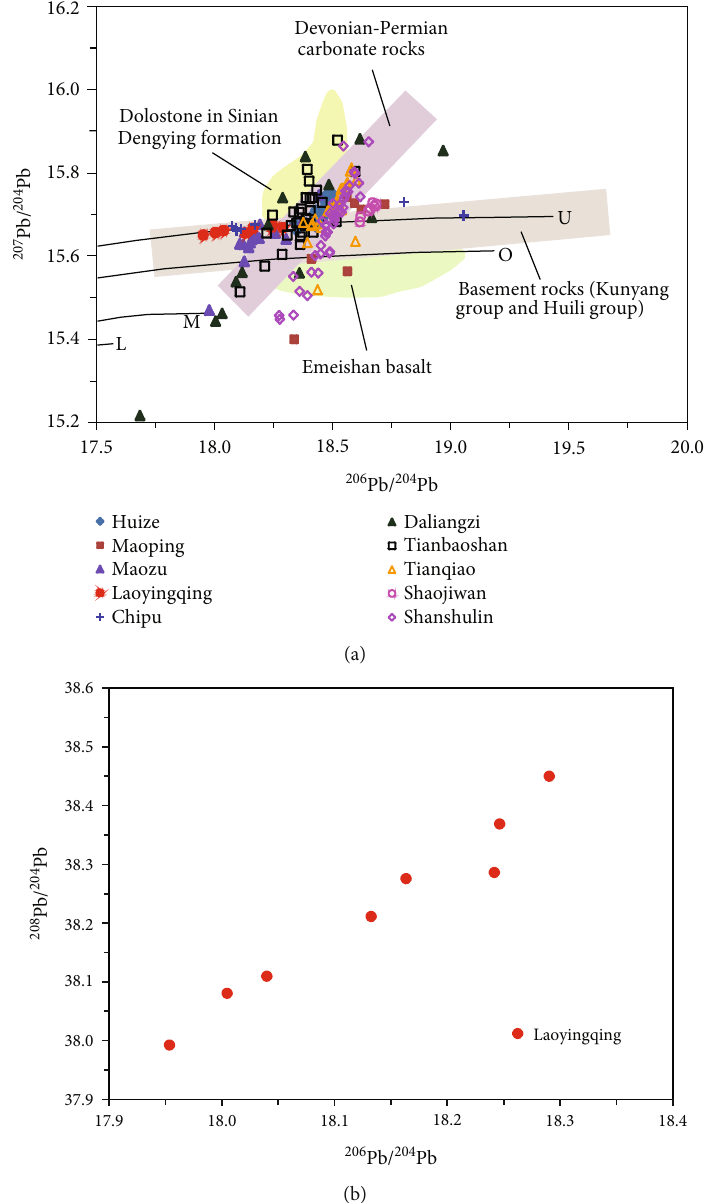
Figure 9: Plots of 207 Pb/ 204 Pb vs. 206 Pb/ 204 Pb for the Laoyingqing Pb – Zn deposit (Trends for the upper crust (U), orogen (O), mantle (M), and lower crust (L) are taken from Zartman and Doe [108]) (a) and Plots of 208 Pb/ 204 Pb – 206 Pb/ 204 Pb for the Laoyingqing Pb – Zn deposit (b). Pb isotope compositions of the Huize deposit are taken from Zhou [109], Han et al. [65], and Li [110]; those of the Maoping deposit are taken from Liu and Lin [6] and Wang et al. [11]; those of the Maozu deposit are taken from Liu and Lin [6] and Zhou et al. [12]; those of the Chipu deposit are taken from Wu [13]; those of the Daliangzi deposit are taken from Zhu et al. [111]; those of the Tianbaoshan deposit are taken from Zhou et al. [17]; those of the Tianqiao deposit are taken from Zhou et al. [8]; those of the Shaojiwan deposit are taken from Zhou et al. [55]; those of the Shanshulin deposit are taken from Zhou et al. [54]. The age-corrected isotopic ranges (200Ma) for the Sinian (Z) Dengying Formation dolostone, the Devonian to Permian (D – P) carbonates, the Proterozoic basement rocks, and the Emeishan basalts are delineated by the data from Hu [33], Liu and Lin [6], Zhou et al. [24], Han et al. [52], and Yan et al.